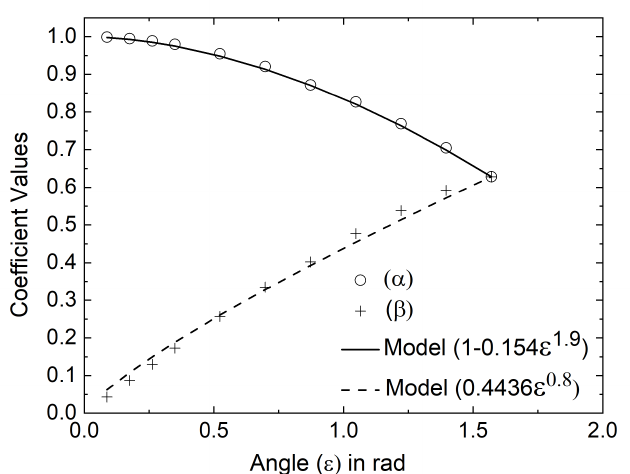
Figure 8. Dependence of the coefficients α and β of Equation (10) on (cid:101) and the model fits suggested by Equations (11) and